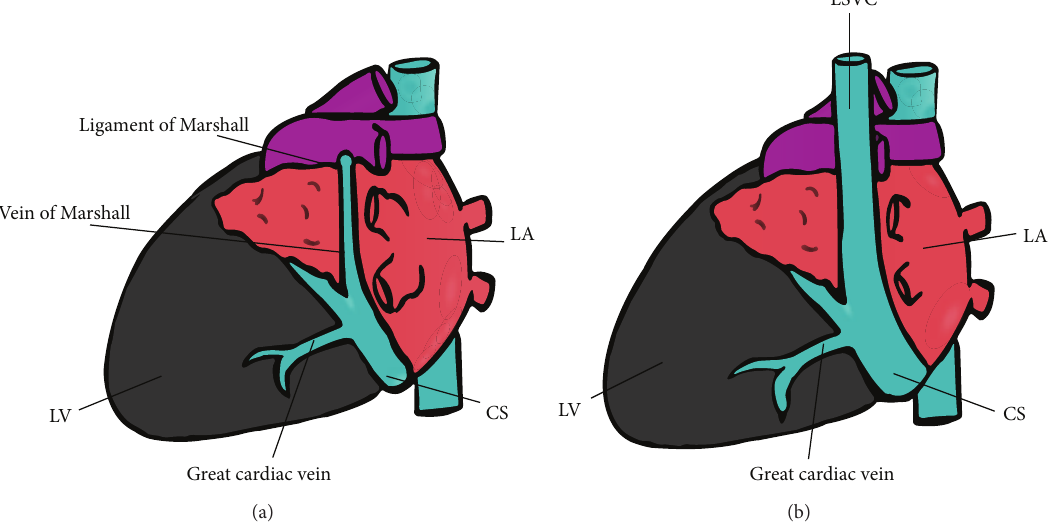
Figure 4: (a) Schematic diagram demonstrating normal venous return to the right atrium. The vein of Marshall regresses during embryologic development, forming the ligament of Marshall. (b) Schematic diagram demonstrating a persistent left superior vena cava which empties into a dilated coronary sinus. The PLSVC results from failure of the vein of Marshall to regress during embryologic